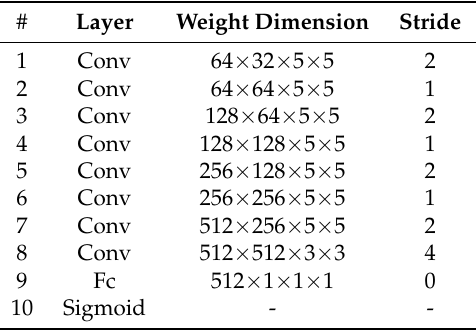
Table 1. Model parameters of the